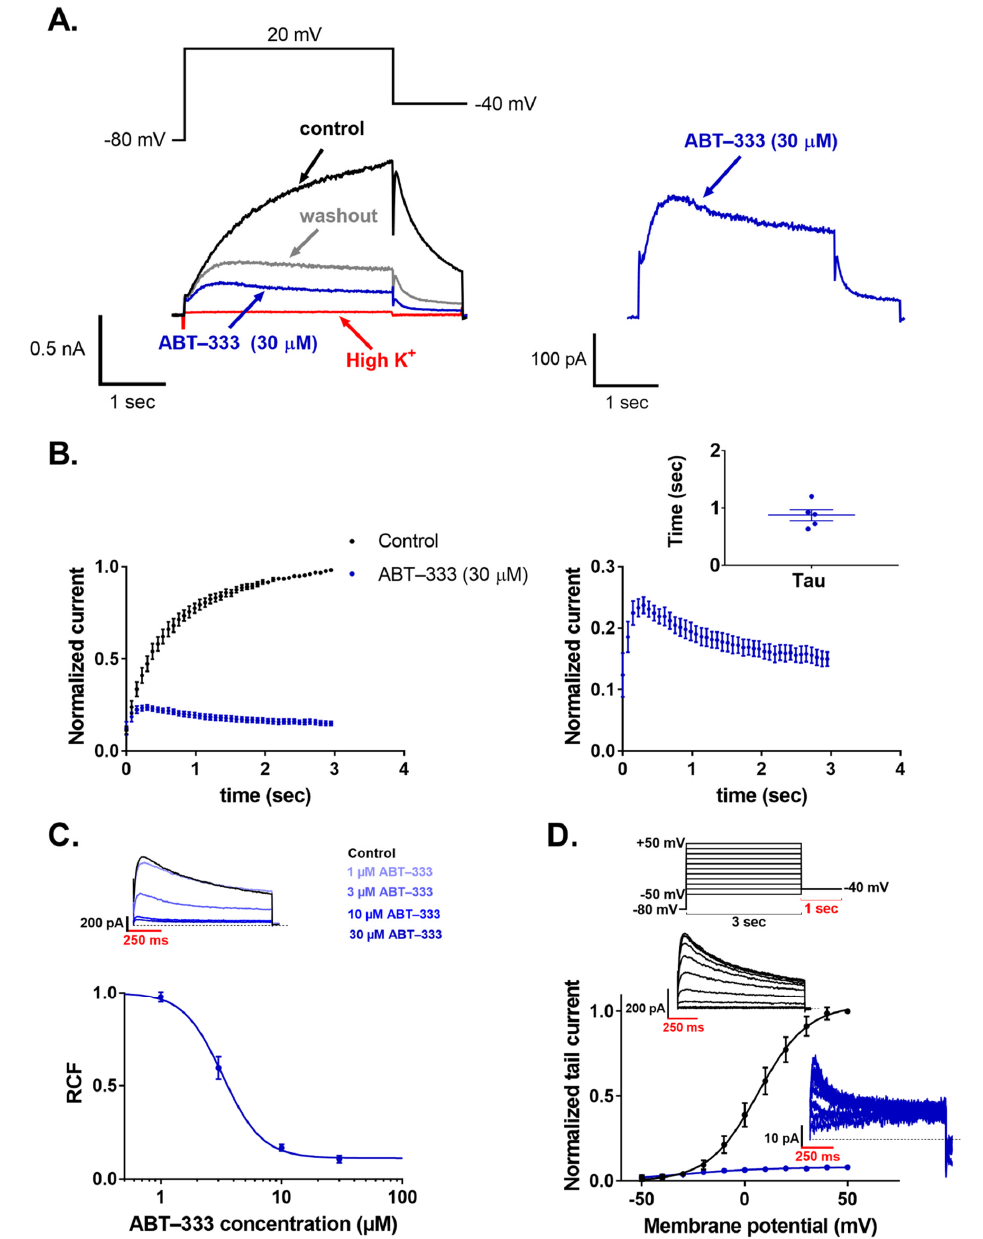
Figure 7. Effects of ABT-333 on hERG current expressed in HEK cells. (( A ) left ) A representative patch-clamp recording in voltage clamp mode. The black trace is the current measured in control solution, while the blue trace is with 30 μ M ABT-333 perfusion (red trace represents perfusion-test high K + application, and gray trace shows washout). (( A ) right ) The trace of the ABT-333 inhibited current is magnified. (( B ) left ) Averaged and normalized (to the peak current in control solution) current traces ( n = 5). (( B ) right ) Magnified version of the ABT-333 time-dependent hERG current inhibition with individual time constants of the current decay (tau) as an inset. ( C ) Concentration– response curve of the ABT-333, which was fit on the 1, 3, 10, and 30 μ M concentrations ( n ≥ 4 for each concentration). Above the dose–response curve, a representative measurement of tail currents is shown in the control condition and during ABT-333 perfusion at the given concentrations. ( D ) G-V curves calculated from data measured in control solution (black) and in 30 µ M ABT-333 (blue) ( n = 3). Above the G-V curve, the voltage protocol is shown, and there are two representative measurements of the tail currents in control condition (black traces) and after the effect of 30 µ M ABT-333 saturated (blue